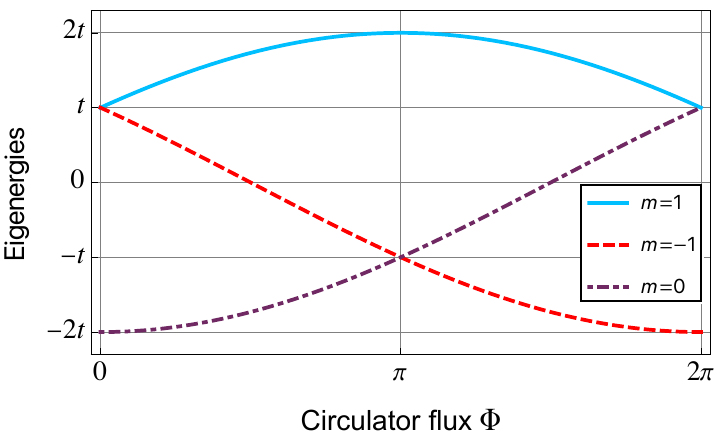
Figure 1: Energy eigenvalues of the three-cavity ring (c.f. Eq. (35)), as a function of the synthetic gauge flux Φ threading the loop; here the hopping amplitude J is denoted t . The energies are labelled according to the wavector k state; m also corresponds to the quantized angular momentum of the eigenstate. At the trivial values of the flux (i.e. Φ = 0, π ,2 π ), the spectrum has a two-fold degener- acy reflecting the presence of time-reversal